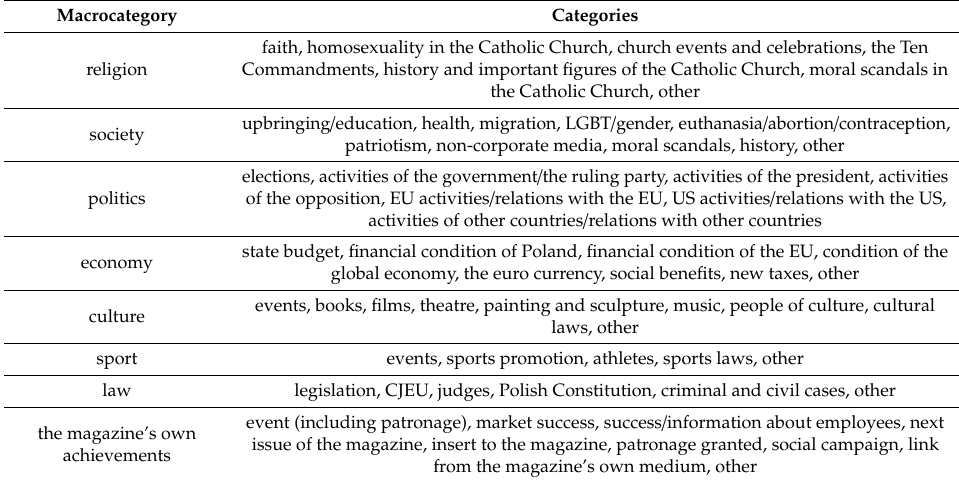
Table 2. Content coding schedule for FB profile—Stage